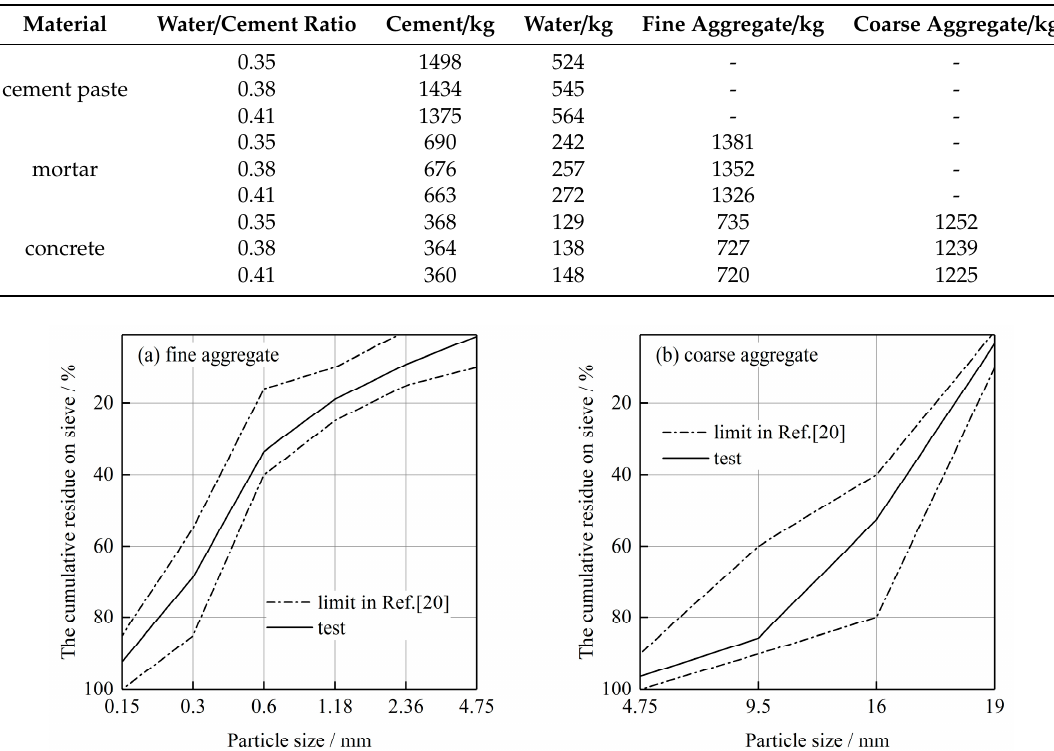
Table 4. Mix proportions of cement paste, mortar, and concrete.